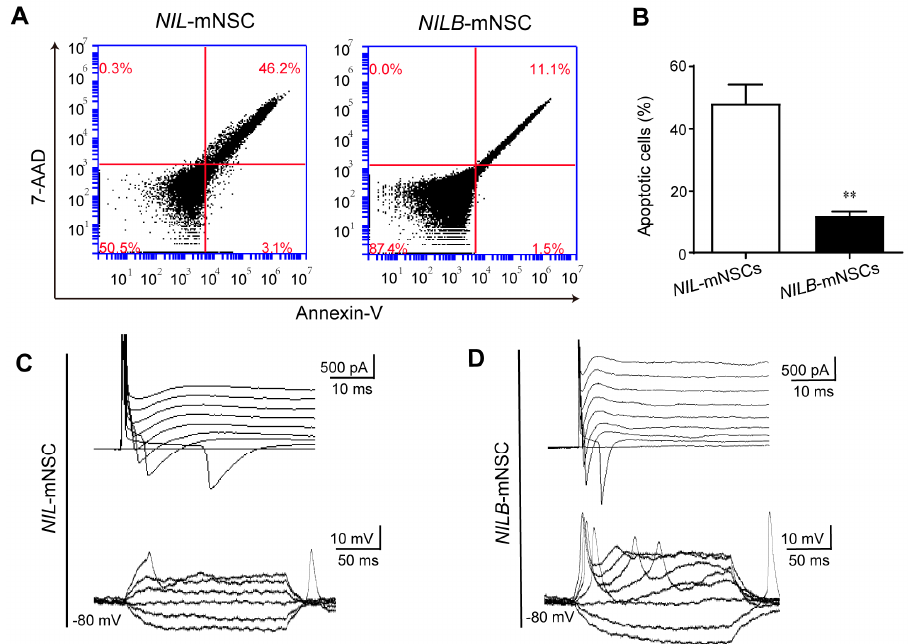
Figure 4. Motor neurons derived from NILB -mNSCs exhibit functional membrane properties in prolonged culture. ( A ) Apoptosis analysis of NIL -mNSCs and NILB -mNSCs by FACS after differentiation for 2 weeks. ( B ) Quantitative analysis of apoptotic cells. Error bars represent SEM; n = 3 separate differentiation experiments each using the genetically modified NIL -mNSCs and NILB -mNSCs; two-tailed Student’s t -test, ** p < 0.01. ( C ) Representative traces of voltage-dependent ion currents and action potentials recorded in NIL -mNSC-derived motor neurons. ( D ) Representative traces of voltage-dependent ion currents and action potentials recorded in NILB -mNSC-derived motor